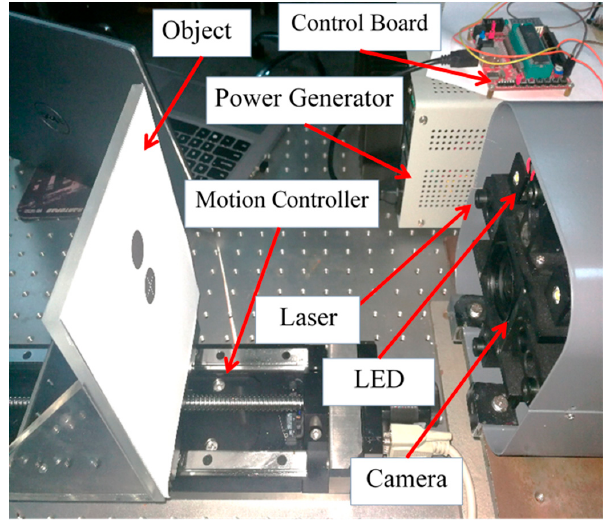
Figure 7. The equipment and devices used to achieve non-contact distance measurement.